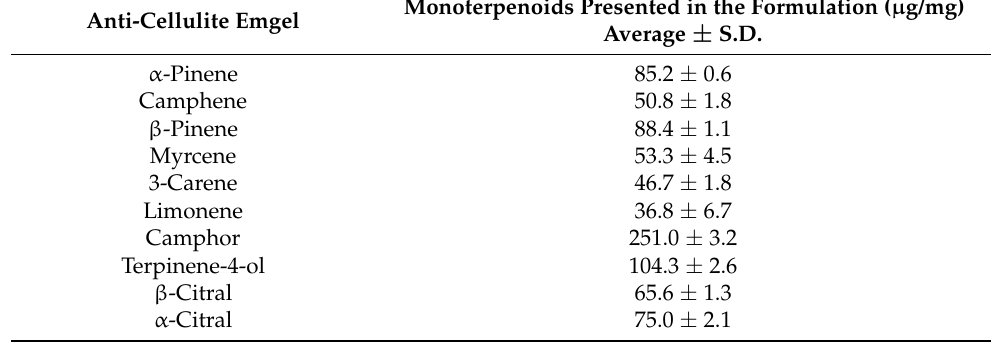
Table 7. The contents of 10 monoterpenoid constituents in the anti-cellulite emgel analyzed by HS- GCMS ( n = 3).